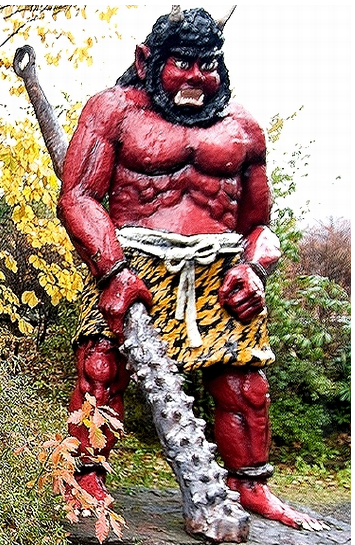
Figure 5. Japanese folklore representation of a